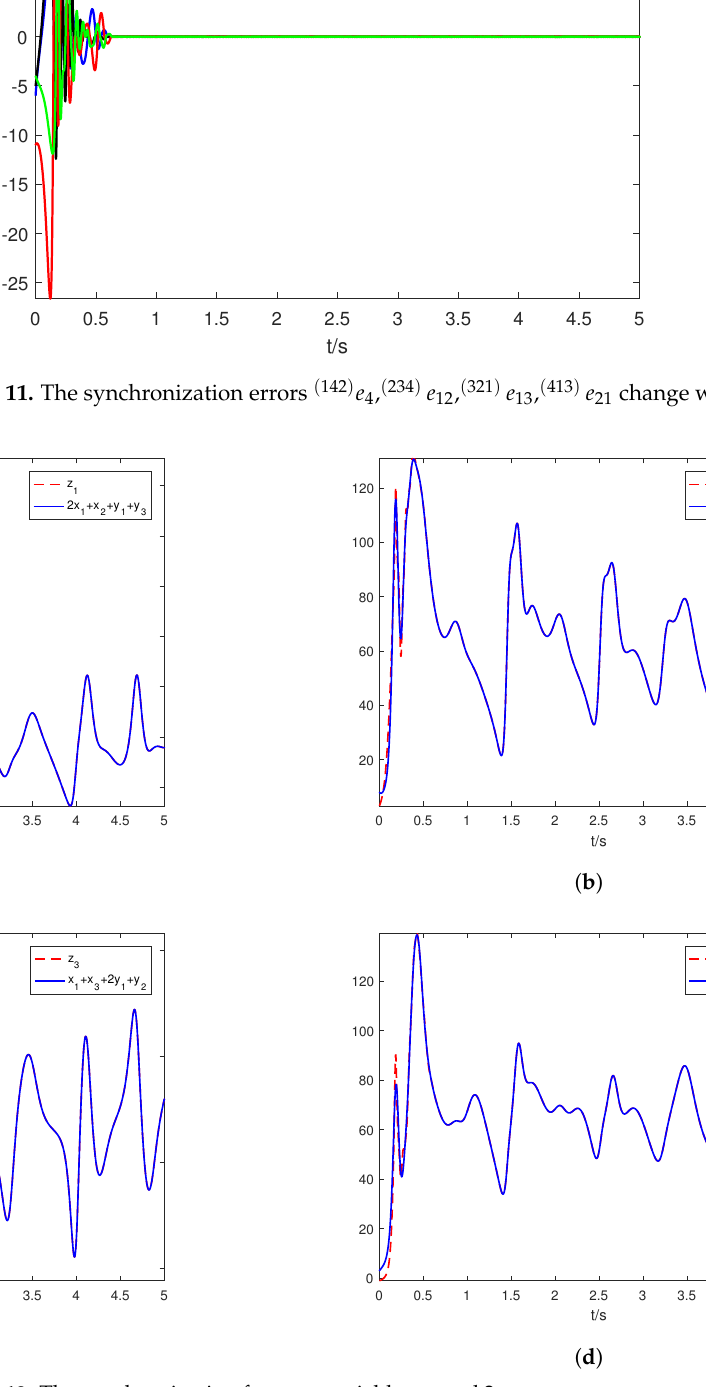
Figure 12. The synchronization for state variables z 1 and 2 x 1 + x 2 + y 1 + y 3 , z 2 and x 1 + x 3 + y 2 + 2 y 3 , z 3 and x 1 + x 3 + 2 y 1 + y 2 , z 4 and x 2 + 2 x 3 + y 1 + y 3 of drive systems (43), (44) and response system (45) indicating in sub-pictures ( a – d ),